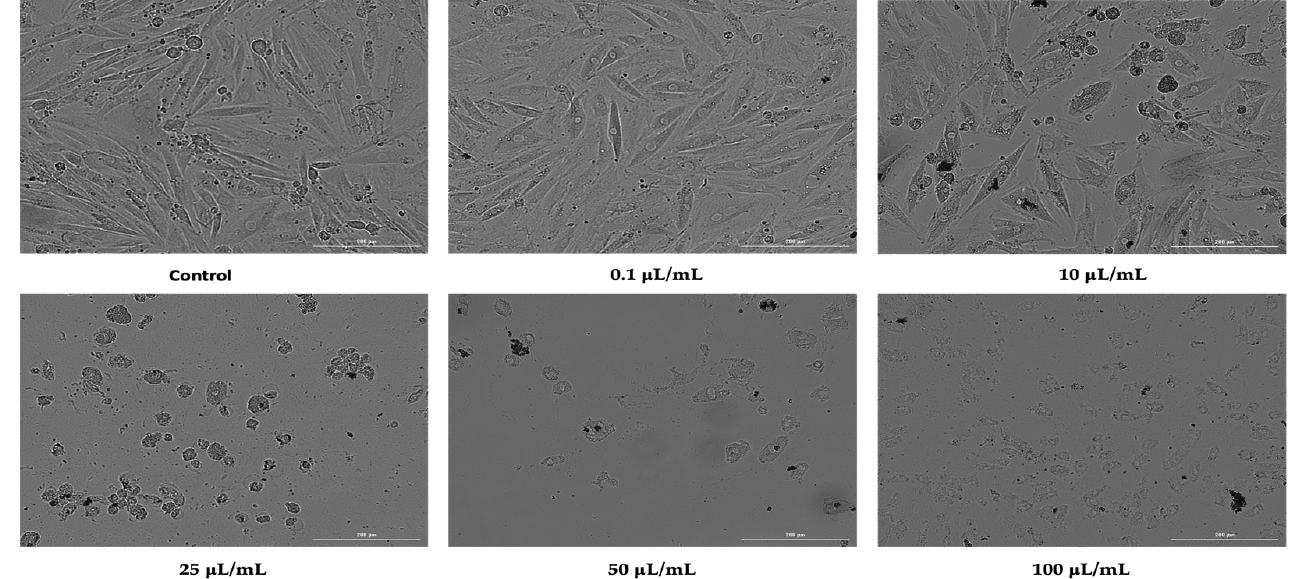
Figure 4. Morphology and confluence of cardiomyocytes (H9C2(2-1)) cells following 24 h treatment with nicotine 0.1, 10, 25, 50, and 100 μ L/mL. The scale bars indicate 200 μ m.